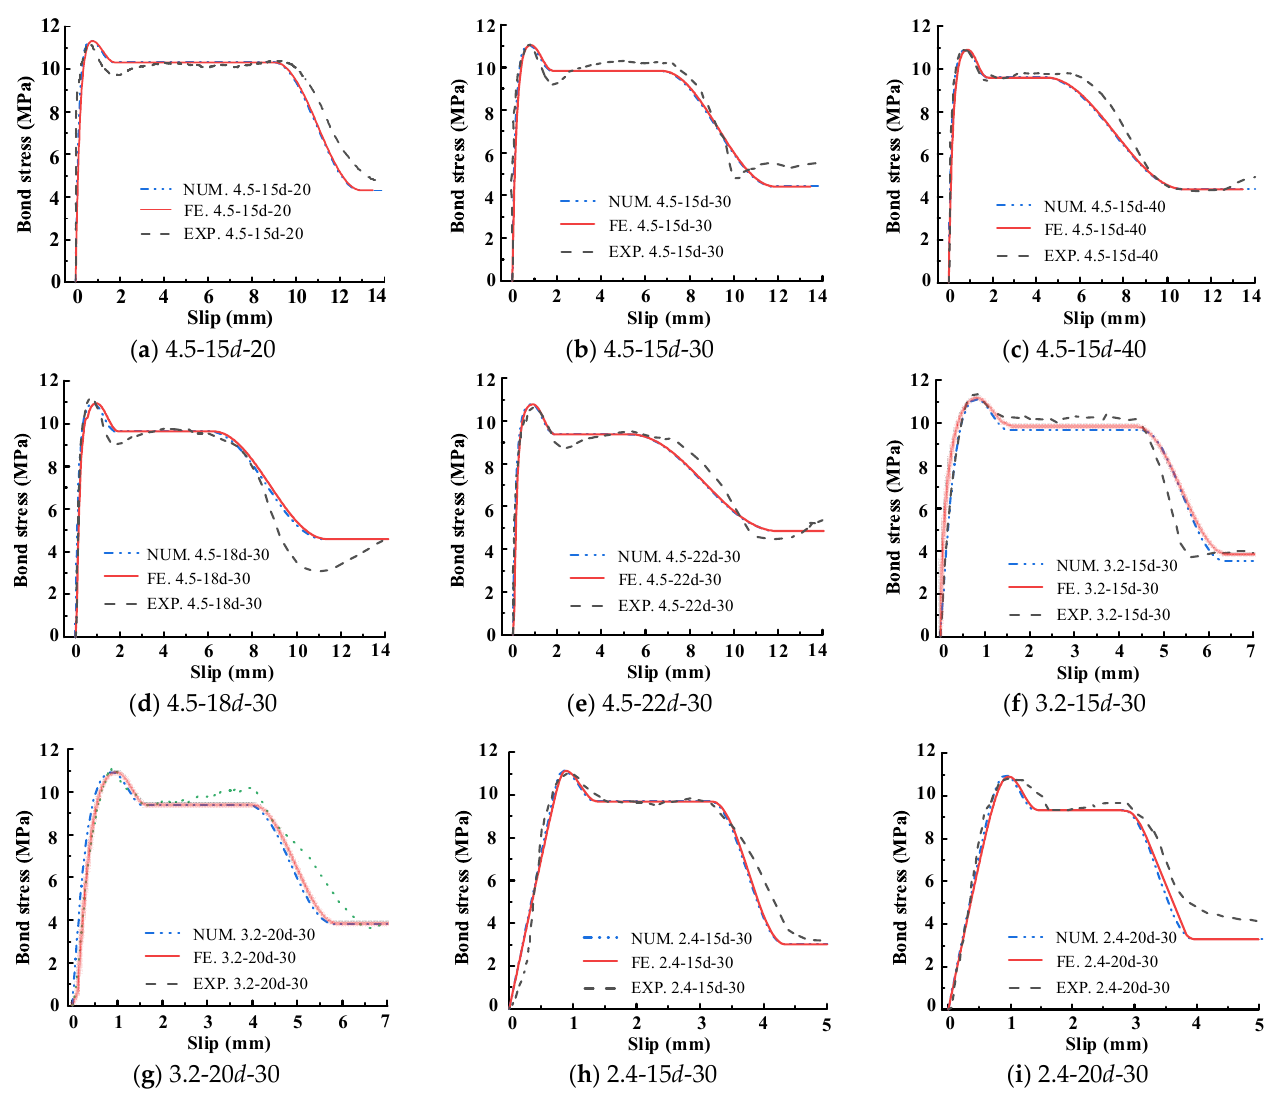
Figure 13. Comparison of bond slip curves of numerical calculation, simulation and test.